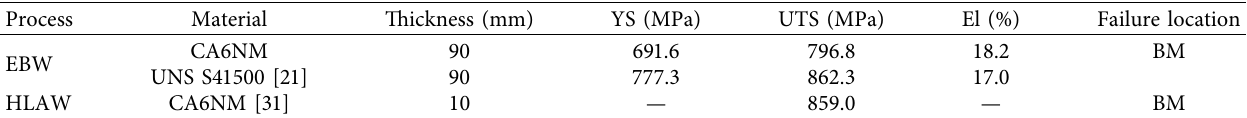
∗ FZ/GL ratio of 0.2 and GL consisting of BM, HAZ, and FZ. Table 5: YS L (MPa) for PWHTed CA6NM samples having different FZ/GL ratios. Sample